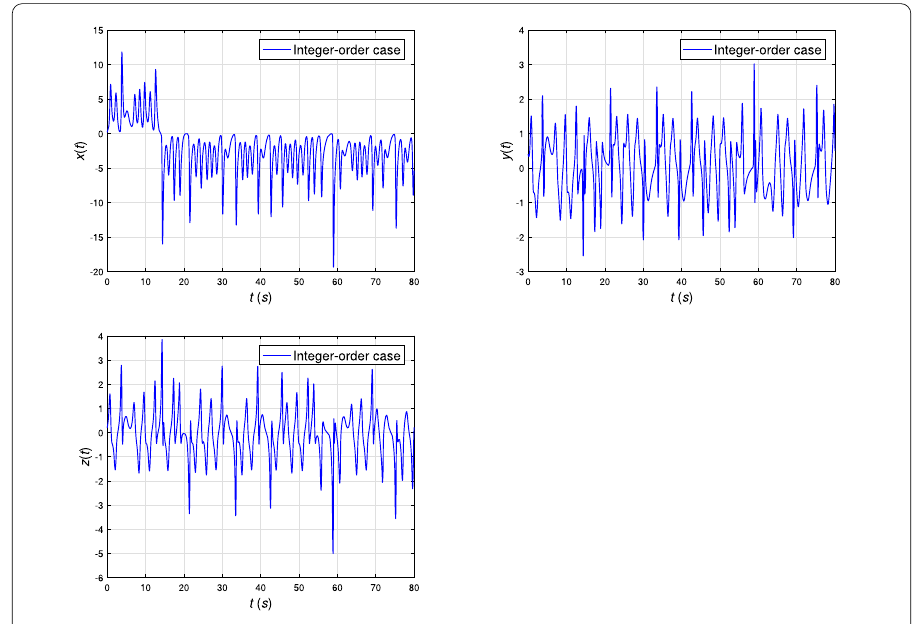
Figure 7 State variables of the integer-order model (16) in the time-domain